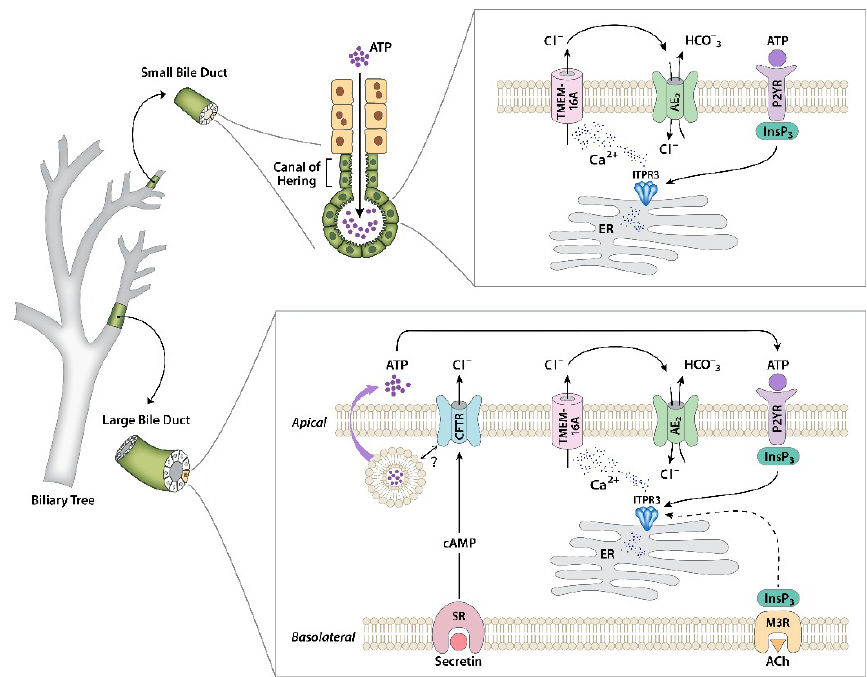
Figure 1. Regulation of bicarbonate secretion in cholangiocytes. Separate signaling pathways that regulate secretion have been identified in large and small cholangiocytes. In large cholangiocytes, secretin receptors (SRs) on the basolateral membrane link to formation of cAMP, which leads to the activation of cystic fibrosis transmembrane conductance regulators (CFTRs), causing apical Cl − efflux. This also stimulates exocytic release of ATP into the ductular lumen, through a mechanism that has not yet been identified. Luminal ATP then binds to apical P2Y receptors to stimulate intracellular Ca 2+ release via inositol 1,4,5-trisphosphate receptor isoform 3 (ITPR3), which in turn activates Cl − secretion through TMEM16A in the apical membrane. The resulting Cl − gradient across the apical membrane drives the AE2 Cl − /HCO 3 − exchanger, resulting in net HCO 3 − secretion. This pathway can also be activated directly by biliary ATP secreted from upstream hepatocytes. Alternatively, inositol 1,4,5-trisphosphate (InsP3) formed from the stimulation of the M3 muscarinic receptor can stimulate secretion, although there is some evidence that this may act through Ca 2+ released from ITPR1 and ITPR2 rather than ITPR3. Small cholangiocytes lack SRs and CFTRs, but have the same apical calcium signaling machinery to link to HCO 3 − secretion that is found in large cholangiocytes. Figure modified in part from References [9,30].